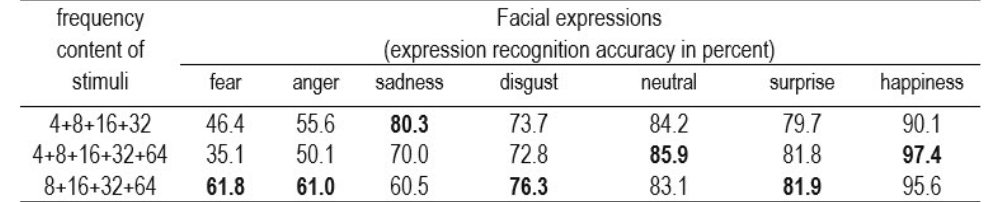
Combinations of spatial-frequency ranges in facial stimuli formed from areas of highest contrast gain, providing the best result of expression